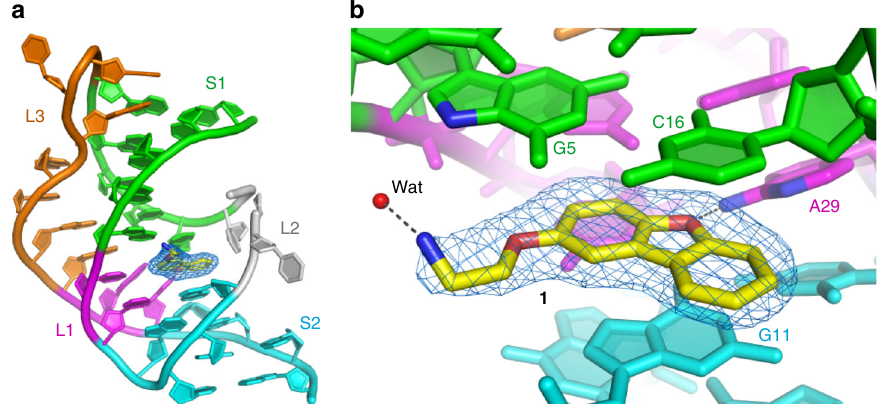
Fig. 6 Co-crystal structure of the aptamer complexed with 1 . a Overall structure of the complex. S1, S2, L1, L2, and L3 are colored green, cyan, magenta, gray, and orange, respectively. The nucleotides between L3 and S2, which interact with L1, are also in magenta. Unbiased | F o | − | F c | electron density map for the compound 1 (blue mesh) contoured at 3.0 σ . b Detail of the ligand-binding site. Nucleotides that interact with 1 are labeled. Dotted lines denote hydrogen bonds between 1 and a bound water molecule and with